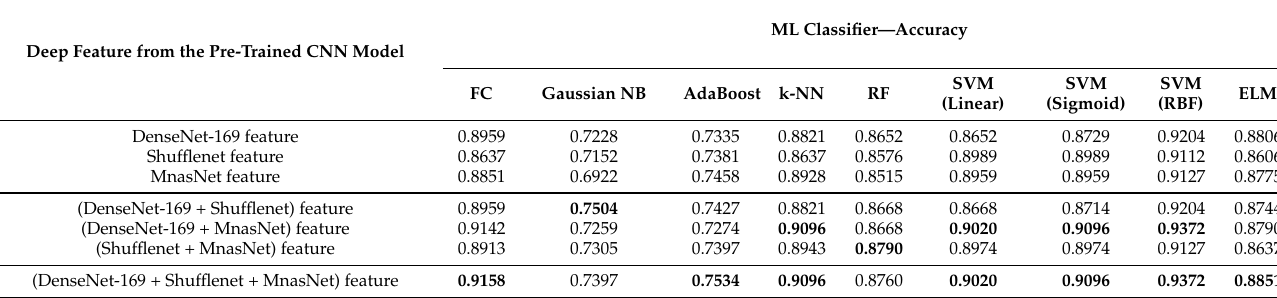
Deep Feature from the Pre-Trained CNN Model